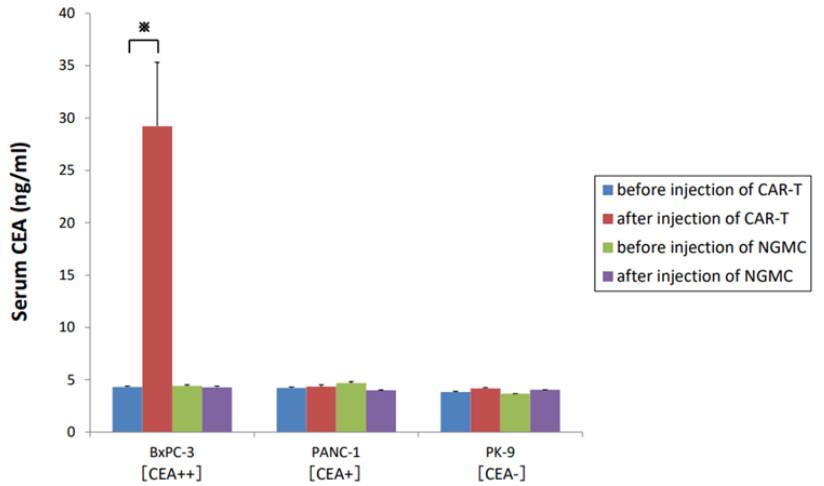
Figure 7. Serum level of CEA was measured by ELISA. Pooled serum samples from mice were collected before and after injection of T cells on days 0 and 21.